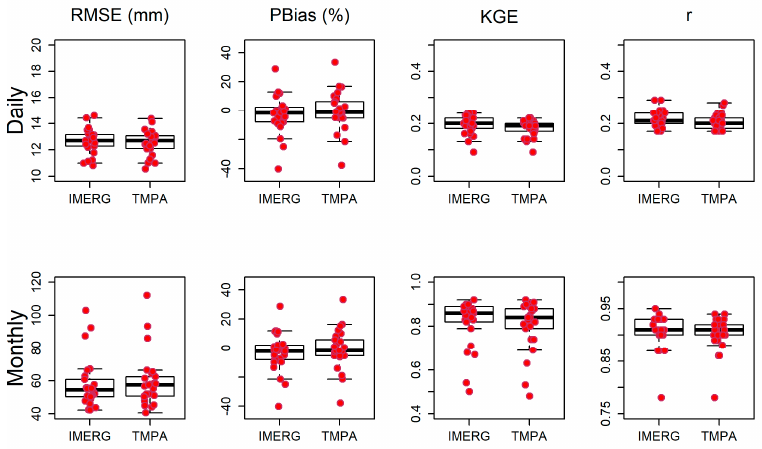
Figure 4. Boxplot of the statistical metrics on a daily and monthly time scale for all rain gauges over the